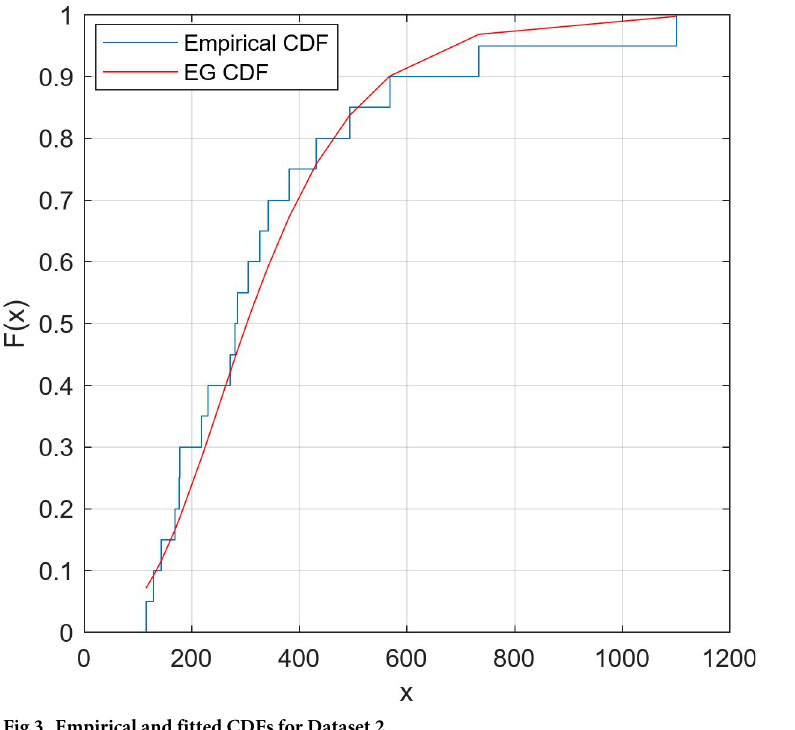
Fig 3. Empirical and fitted CDFs for Dataset